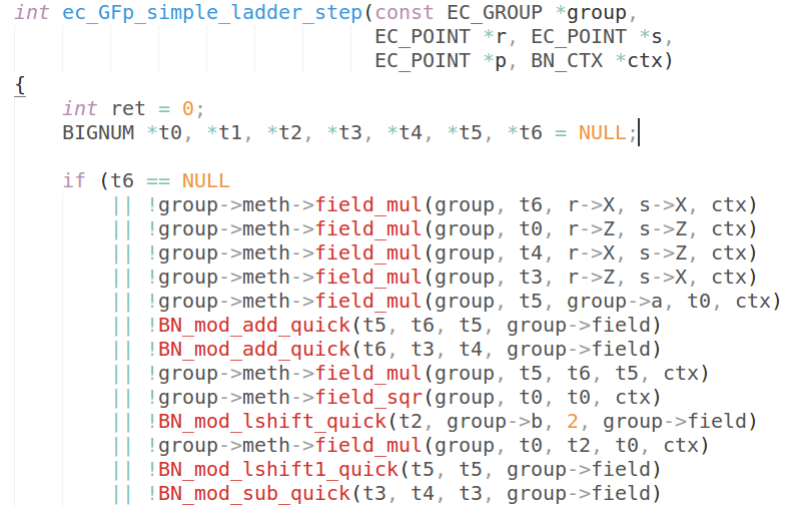
Figure 9: Code snippets for Montgomery Ladder step with differential addition-and- doubling in OpenSSL